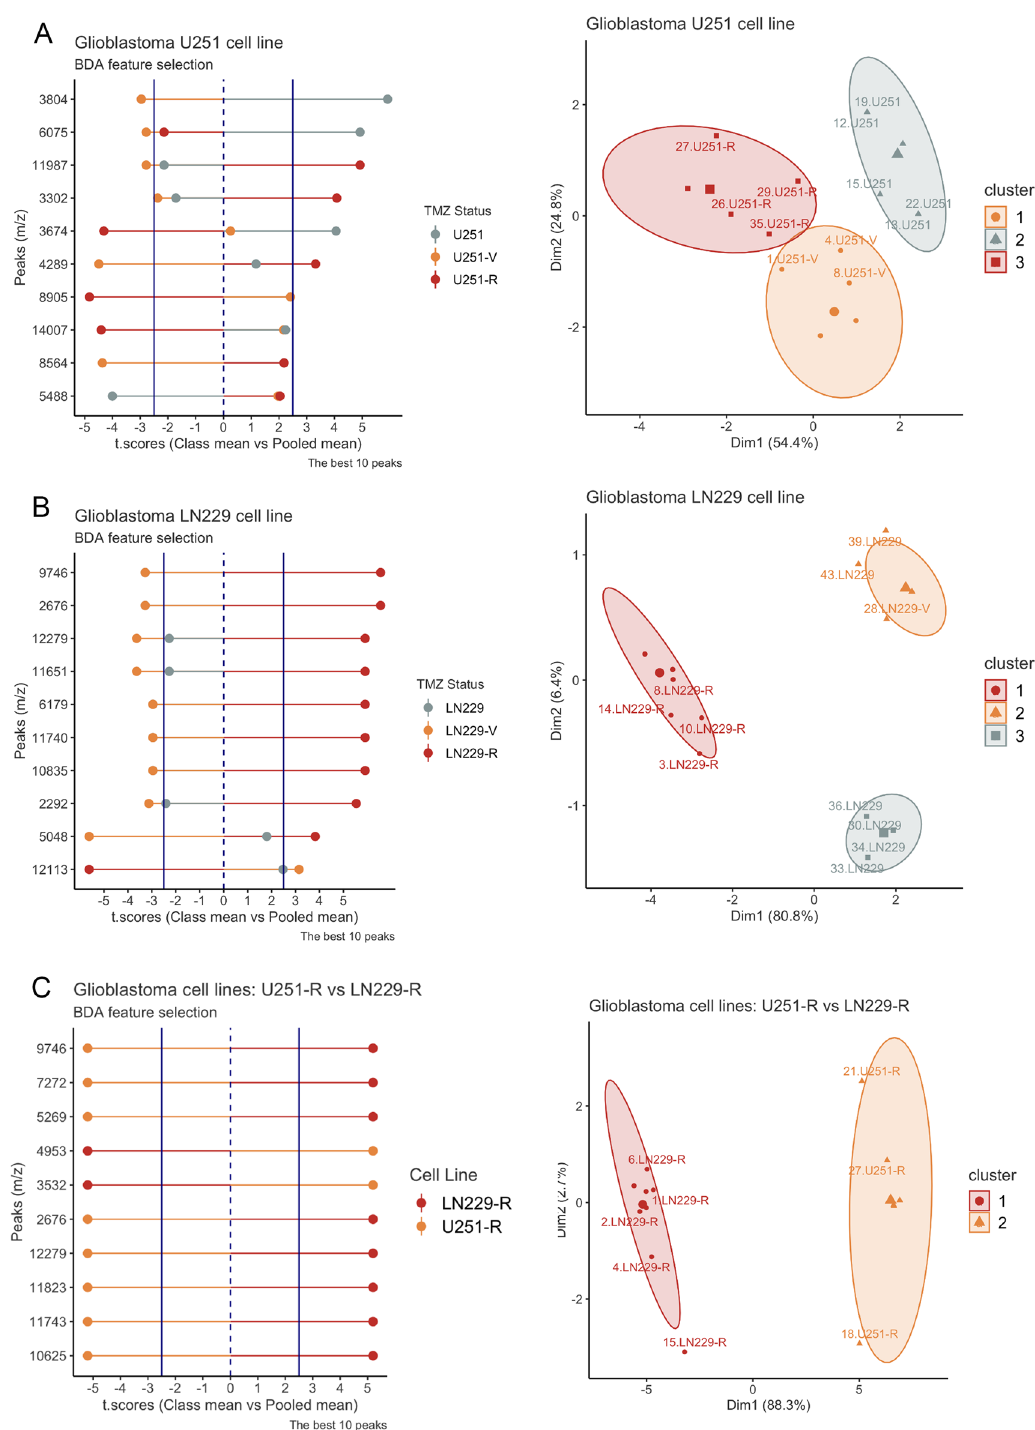
Figure 4. MALDI-TOF-MS analysis for the GBM model. Left panel: comparison between ( A ) U251/ U251-V/ U251-R, ( B ) LN229/ LN229-V/LN229-R, and ( C ) U251-R/LN229-R for the selection of discriminant peaks by the BDA algorithm. The algorithm outputs the t.score (group means vs. pooled mean), which is graphed in the x-axes of both graphs, and the peaks (m/z) are plotted on the y-axis. The sign of the t.score indicates the presence (positive) or the absence (negative) of that peak in that group. The groups are indicated with different colors. The differences have a 95% significance when the value of the t.score is equal to or greater than 2.5 (increased) and equal to or less than − 2.5 (diminished). Right panel: Spectra pattern comparison between ( A ) U251/ U251-V/U251-R, ( B ) LN229/ LN229-V/ LN229-R, and ( C ) U251-R/LN229-R, was performed by the Hierarchical k-means clustering with a Principal Component Analysis visualization (HKmC-PCA). Each point on the graph corresponds to each experimental replicate. The label indicates an ID number of the spectrum and the cell line name. The spectra patterns were grouped in 3 clusters represented by different geometric symbols and colors. Lastly, the ellipses of each cluster represent 95% of confidence from the centroid, considering a normal distribution